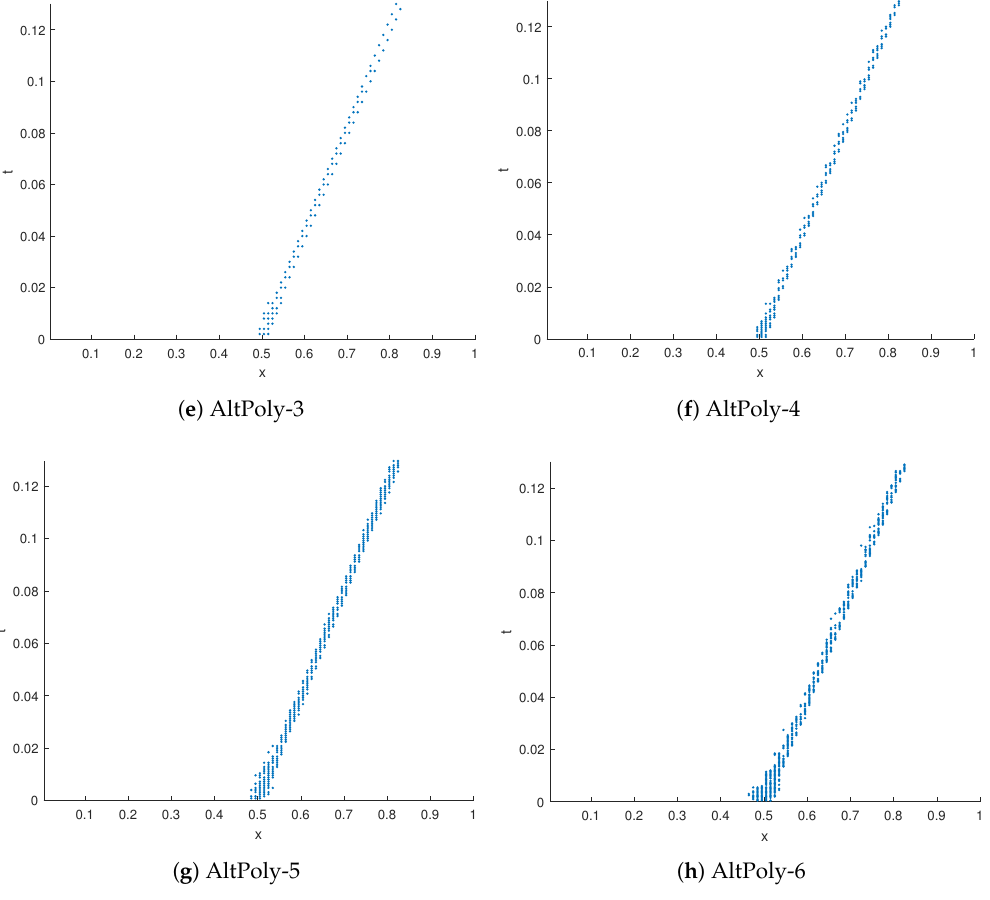
Figure 8. The cells where artificial viscosity takes effect in Lax’s